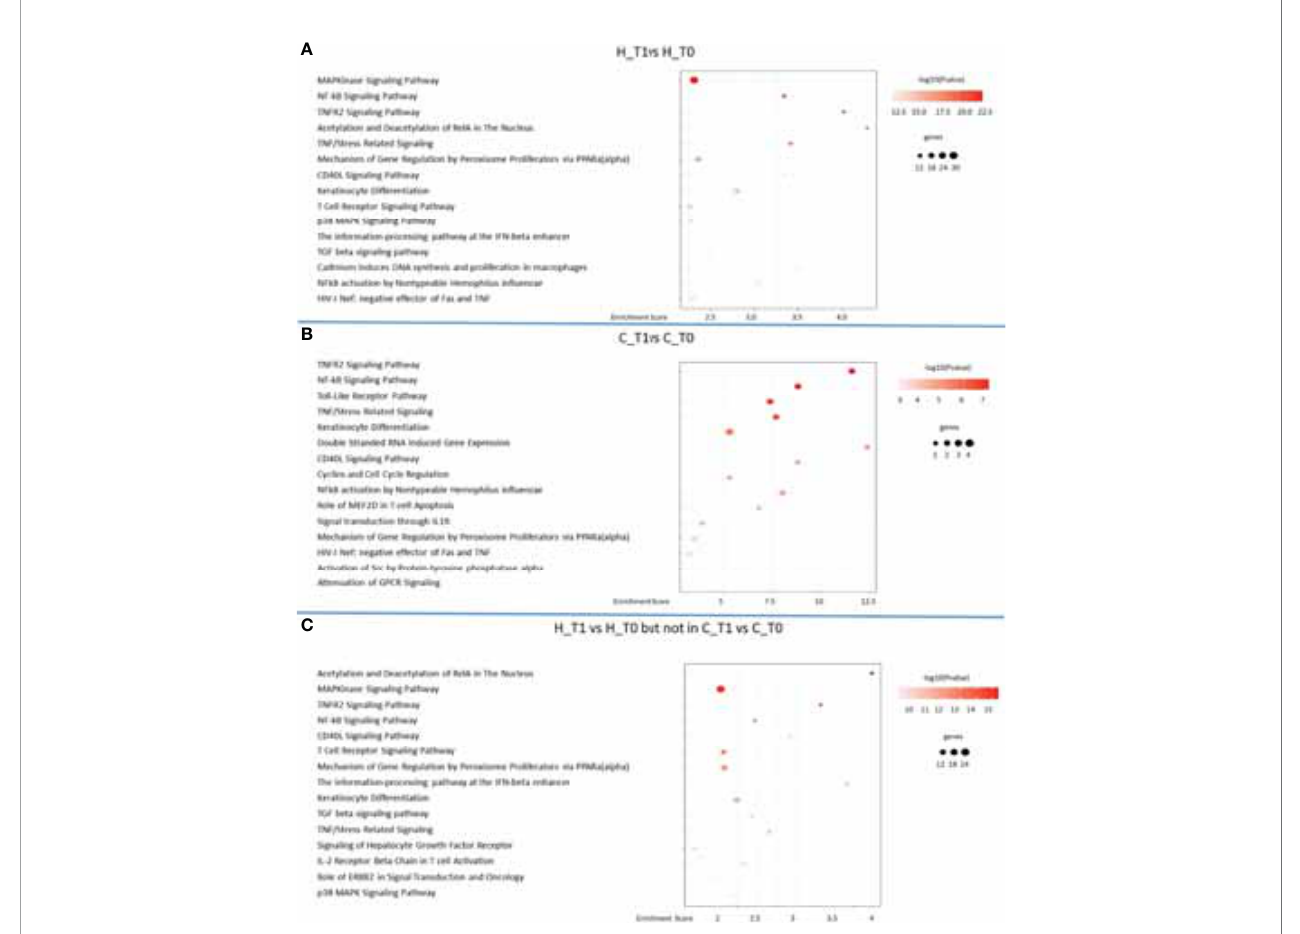
FIGURE 3 | The 15 most signi fi cant pathways identi fi ed in goats fed with hemp seeds (H) plot (A) and the control (C) group plot (B) in the time course (T0 and T1) and after a comparison between the two diets plot (C)